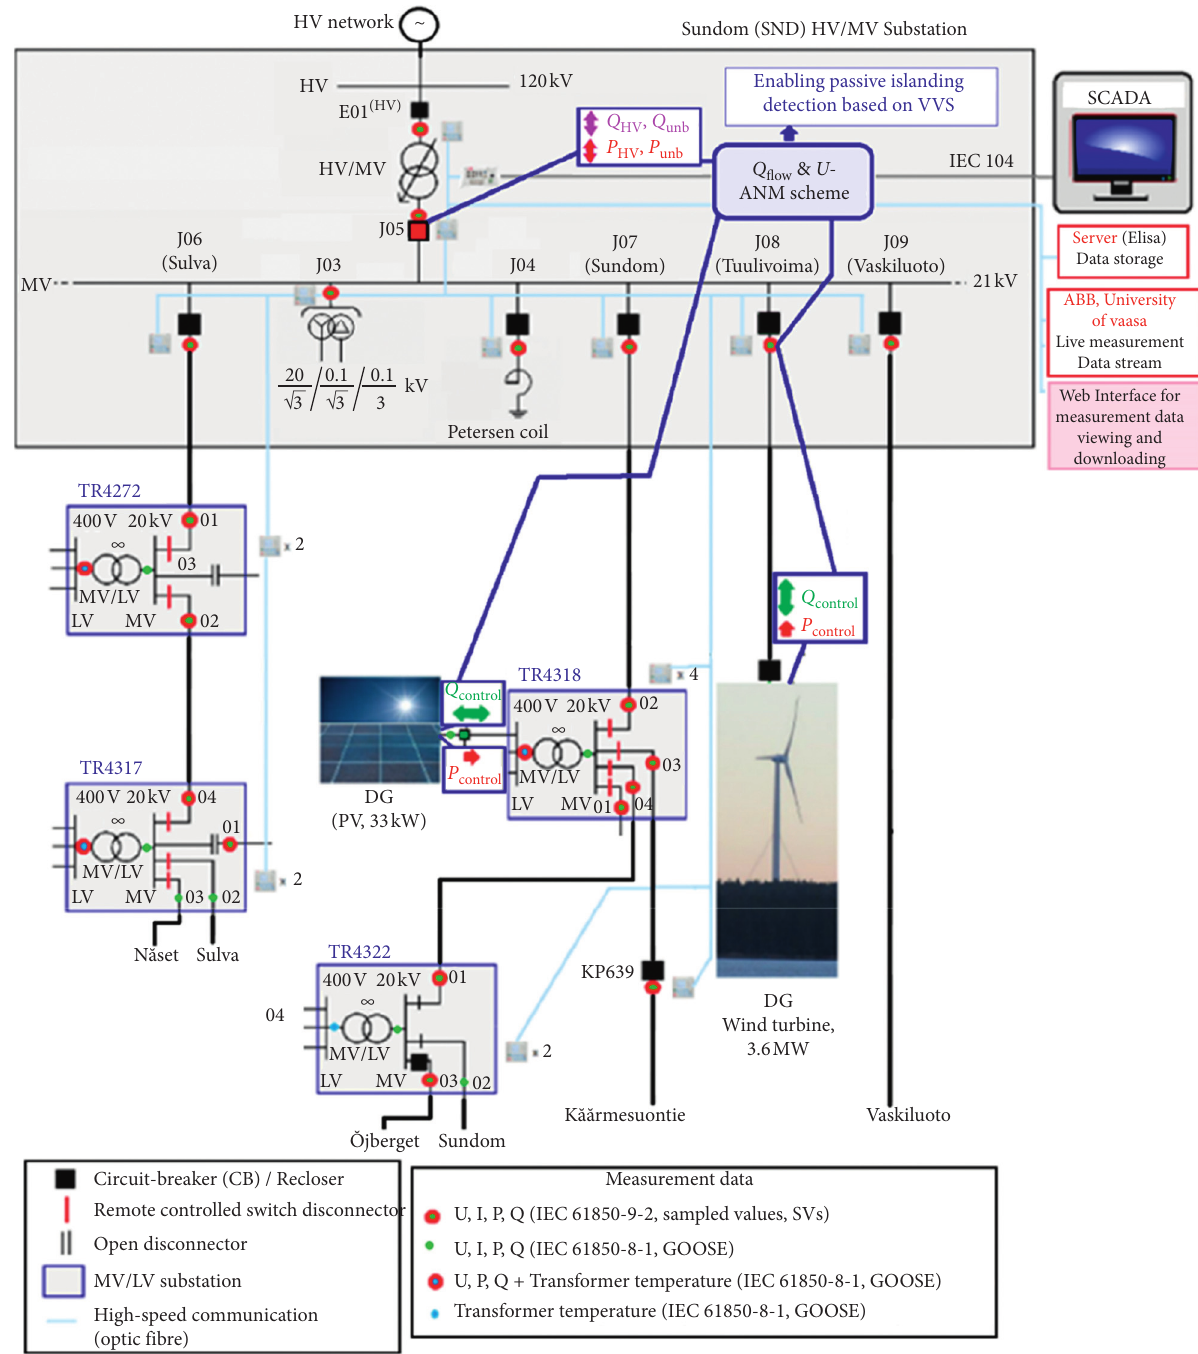
Figure 3: Sundom Smart Grid